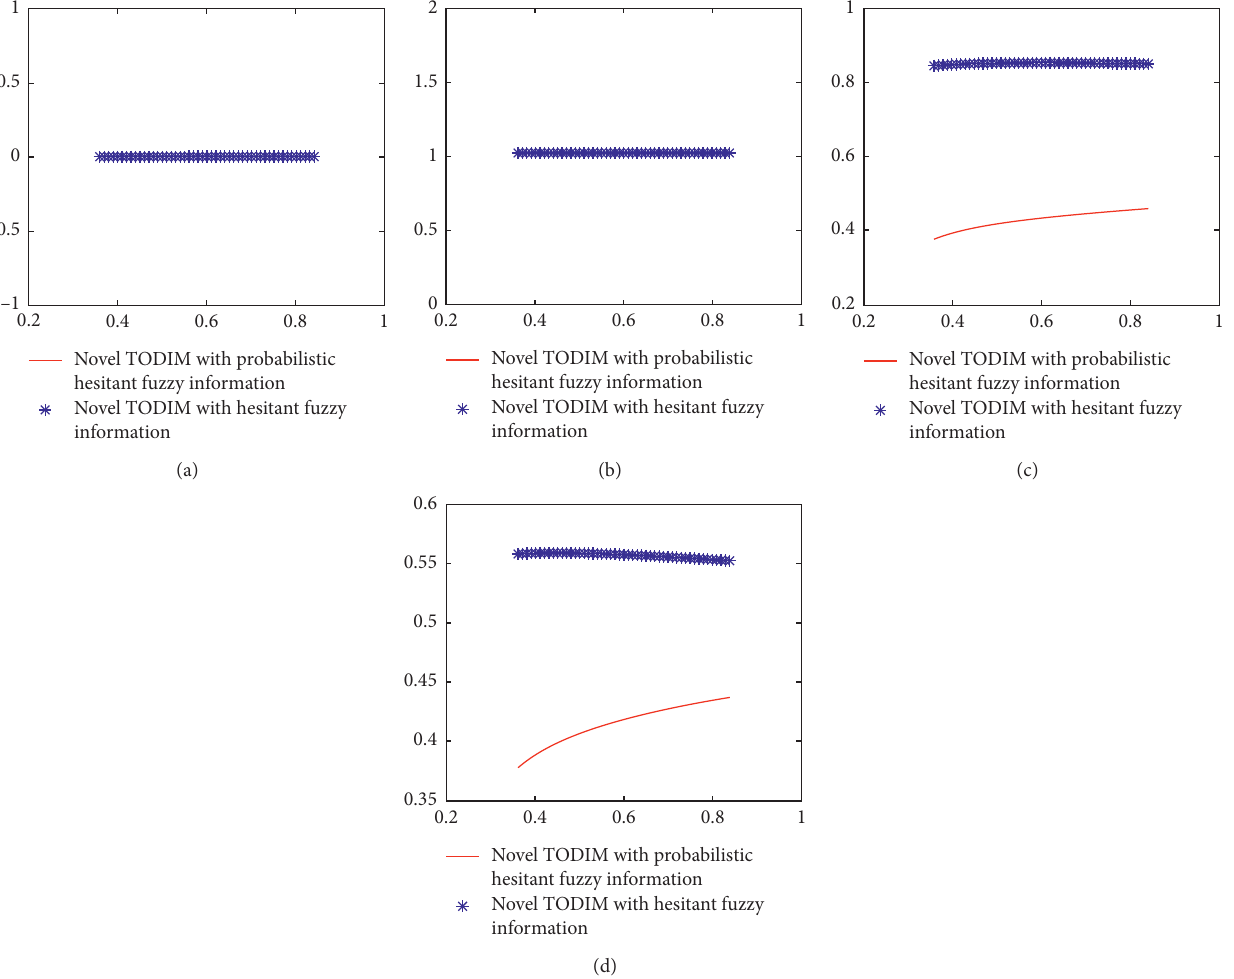
Figure 7: Sensitivity analysis of the novelTODIM by changing δ . 0 . 36 ≤ δ ≤ 0 . 84, α � β � 0 . 88, c � 0 . 61, and λ � 2 . 25. (a) A